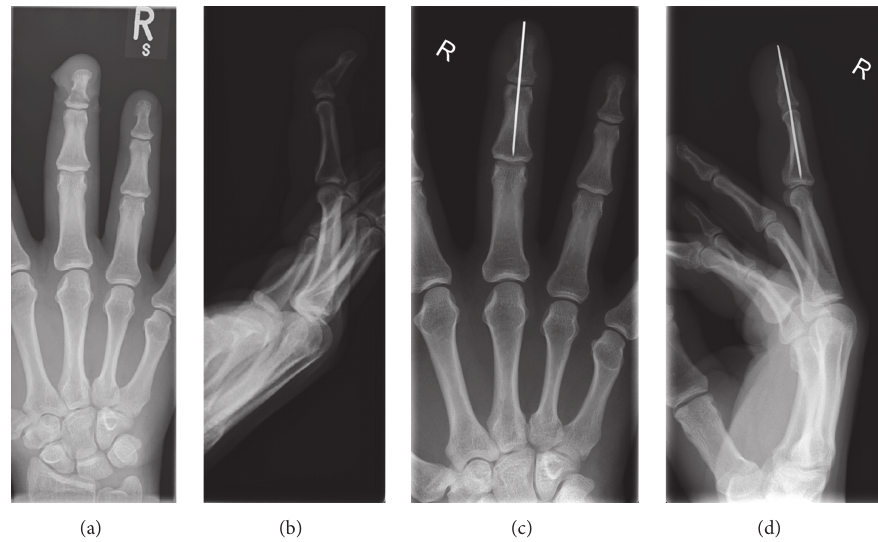
Figure 1: X-rays showing displaced oblique fracture of right middle finger distal phalanx (a, b), which was treated with Kirschner wire fixation (c, d).